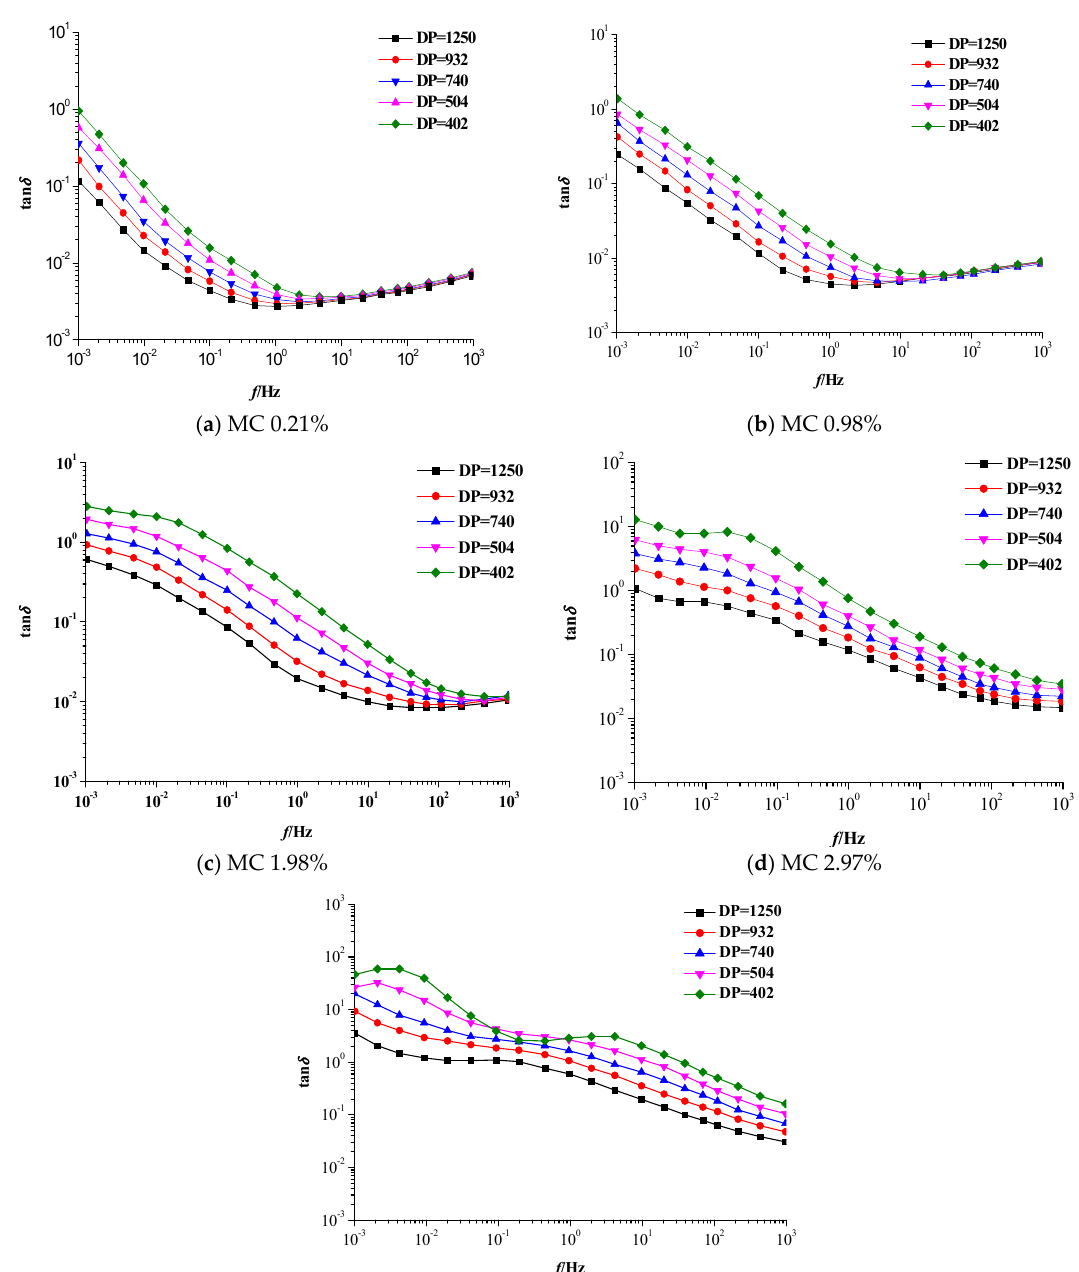
Figure 2. The tan δ curve of samples under different aging degree in set A~E.